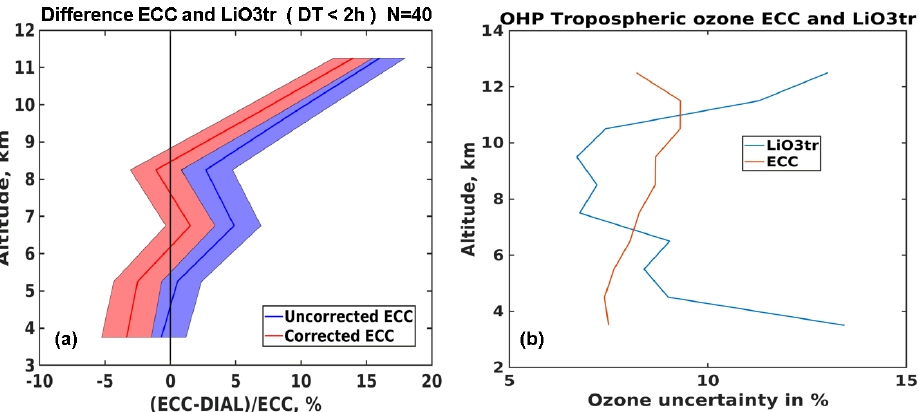
Figure 5. (a) Mean relative ECC minus LiO3Tr ozone concentration differences (in %) between 3 and 12km for uncorrected (blue) and homogenized (red) ozonesonde. Shaded areas represent the statistical standard uncertainty in the mean difference. (b) Vertical profiles of the median of the relative ozone concentration uncertainty in the troposphere for the homogenized ECC (red) and LiO3Tr